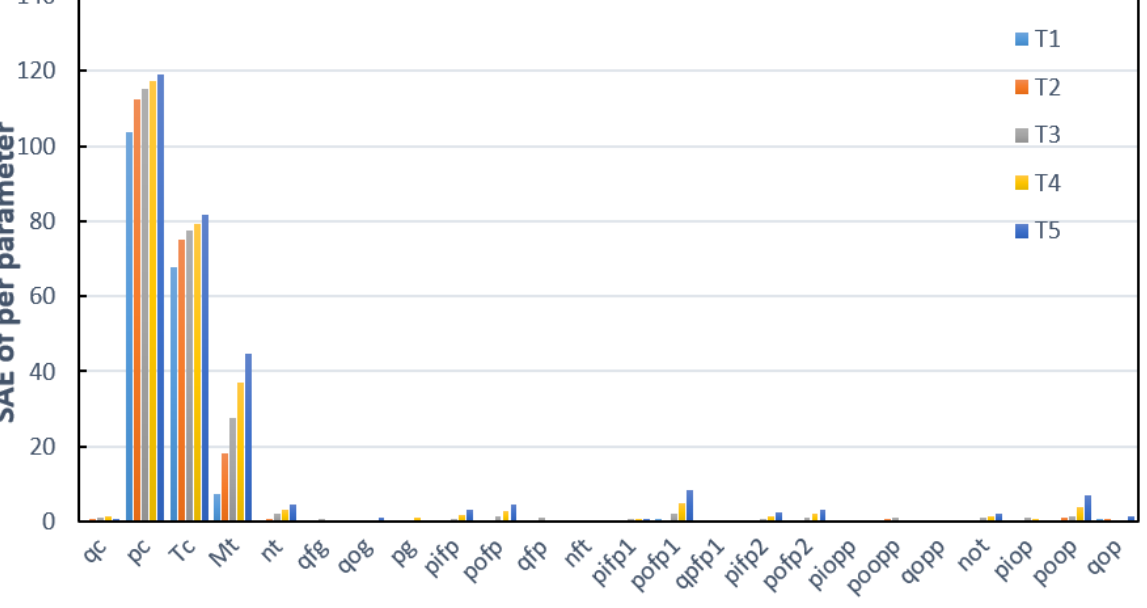
Figure 9. SAE of five consecutive samples after injection fault of test 12.